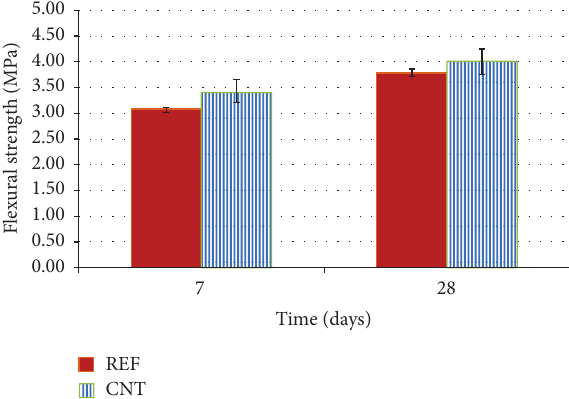
Figure 7: Flexural strength of cement mortars with and without CNT after 7 and 28 days. There is obvious increase in mortars’ strength with CNT’s